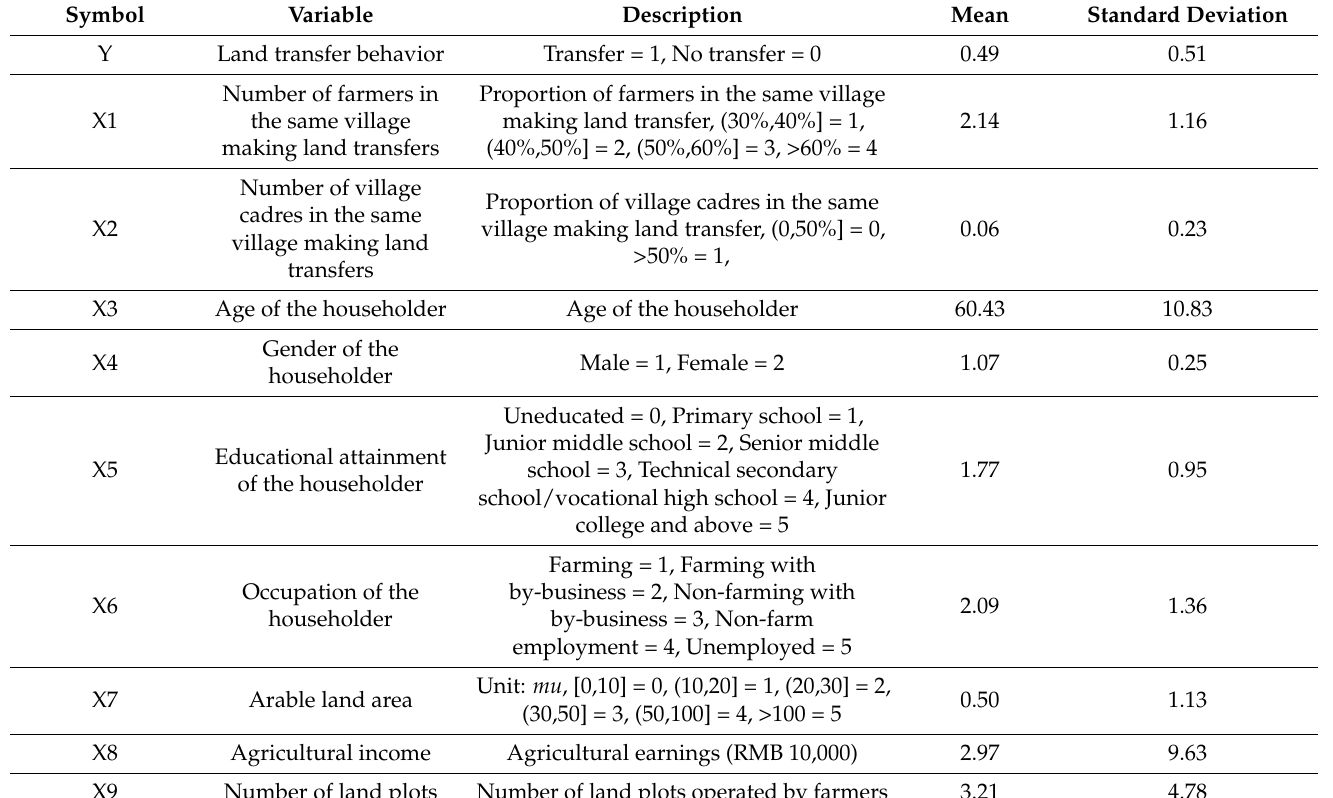
Table 1. Variables and their symbols and